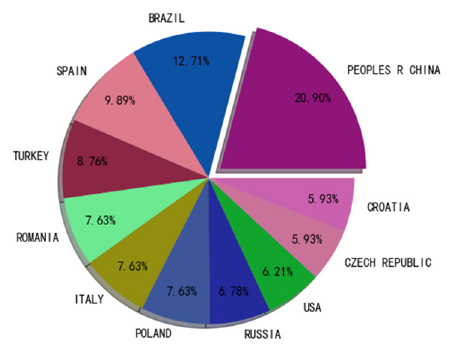
Figure 5. Pie chart of papers published in different countries.